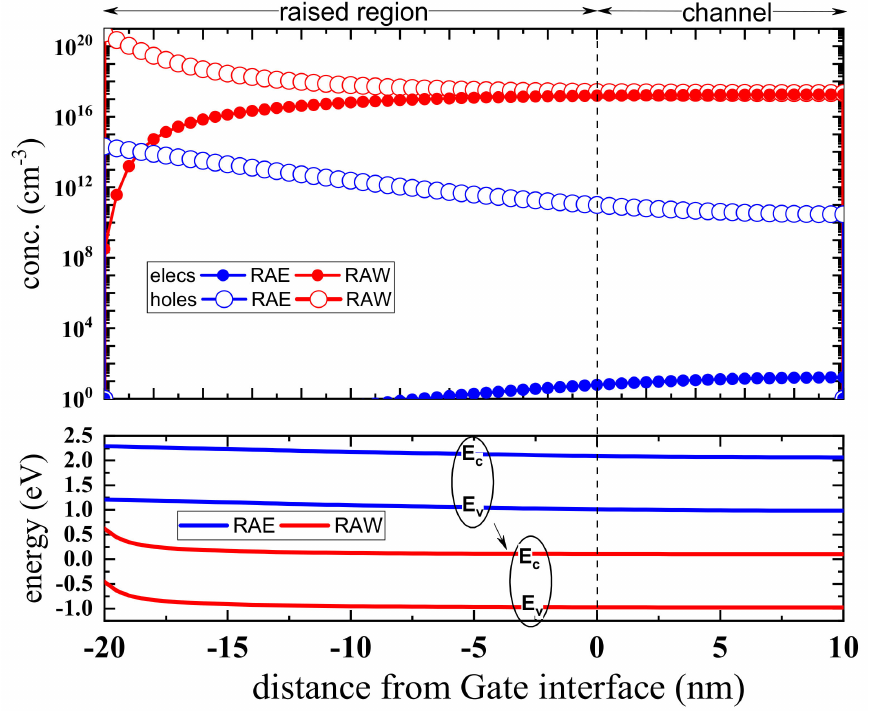
Figure 6. Cutlines in the y direction at the center of the device (x = 0) of ( Top ) electron and hole concentrations and ( Bottom ) energy bands at the end of RAE/RAW operations. The bias point is V G,READ = − 2 V, with t READ = 5 ns and t HOLD =